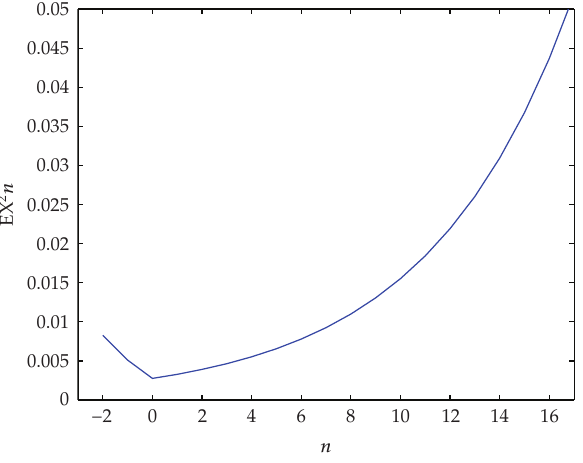
Figure 1: Mean square exponential stability of (cid:3) 5.1 (cid:4) : a (cid:7) 0 . 5, b (cid:7) 0 . 25, c (cid:7) 0 . 25, m (cid:7) 9, η k (cid:7) 10 k , and β